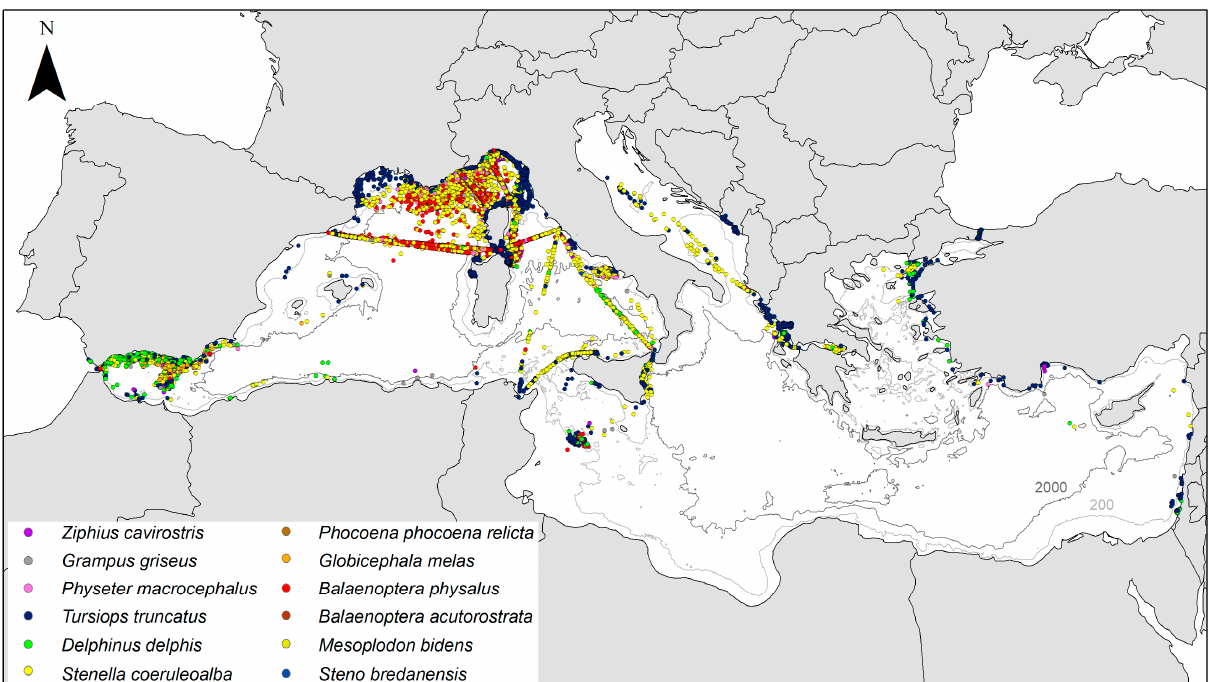
Figure 4. In the period analysed (2004–2018), a total 17,763 sightings, consisting of 12 different cetacean species, were recorded by the research units.